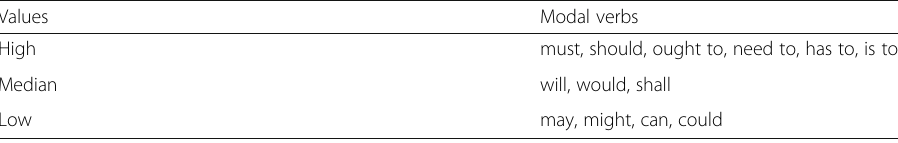
Table 3 Different Value Degrees of Modal Verbs Values Modal verbs High must, should, ought to, need to, has to, is to Median will, would, shall Low may, might, can, could